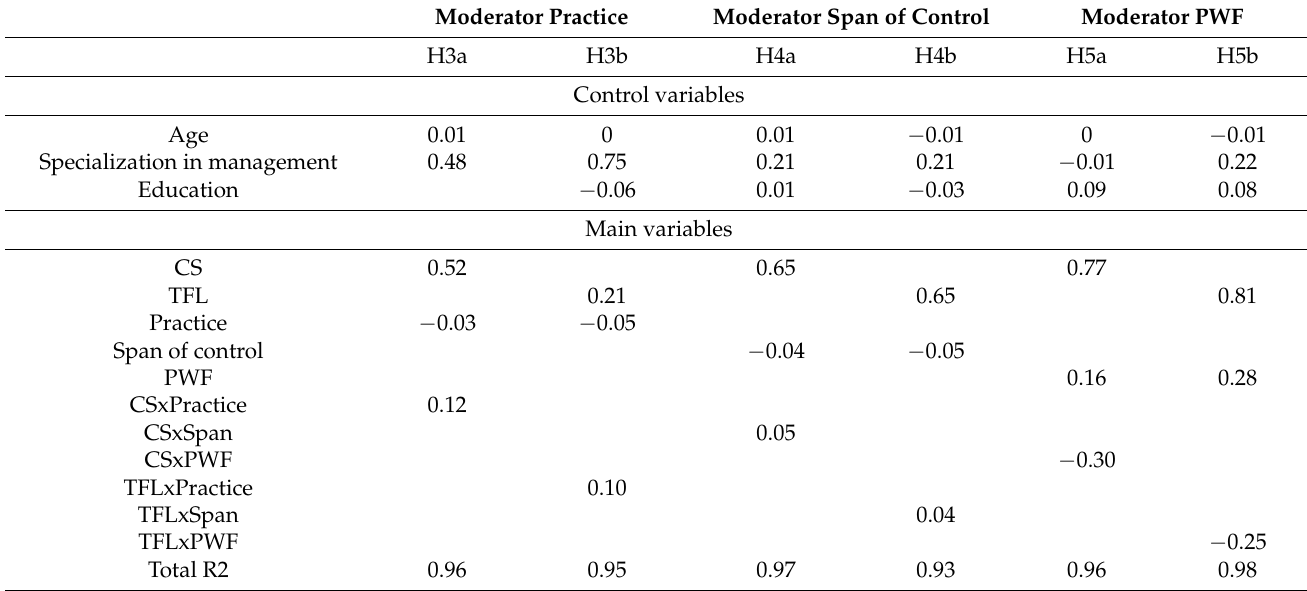
Table 3. Results of moderated regression analyzes.